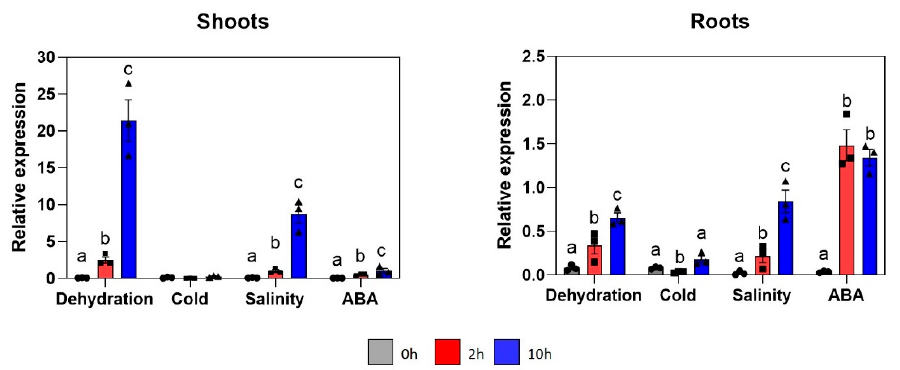
Figure 1. Expression profiles of GmNAC085 in shoot and root tissues of soybean cultivar DT51 under dehydration, cold, salt and abscisic acid (ABA) treatments. Each value represents the mean ± SE ( n = 3). Significance in transcriptional changes over the course of each treatment was analyzed by ANOVA and Tukey’s honestly significant difference and indicated by different letters ( p < 0.05).